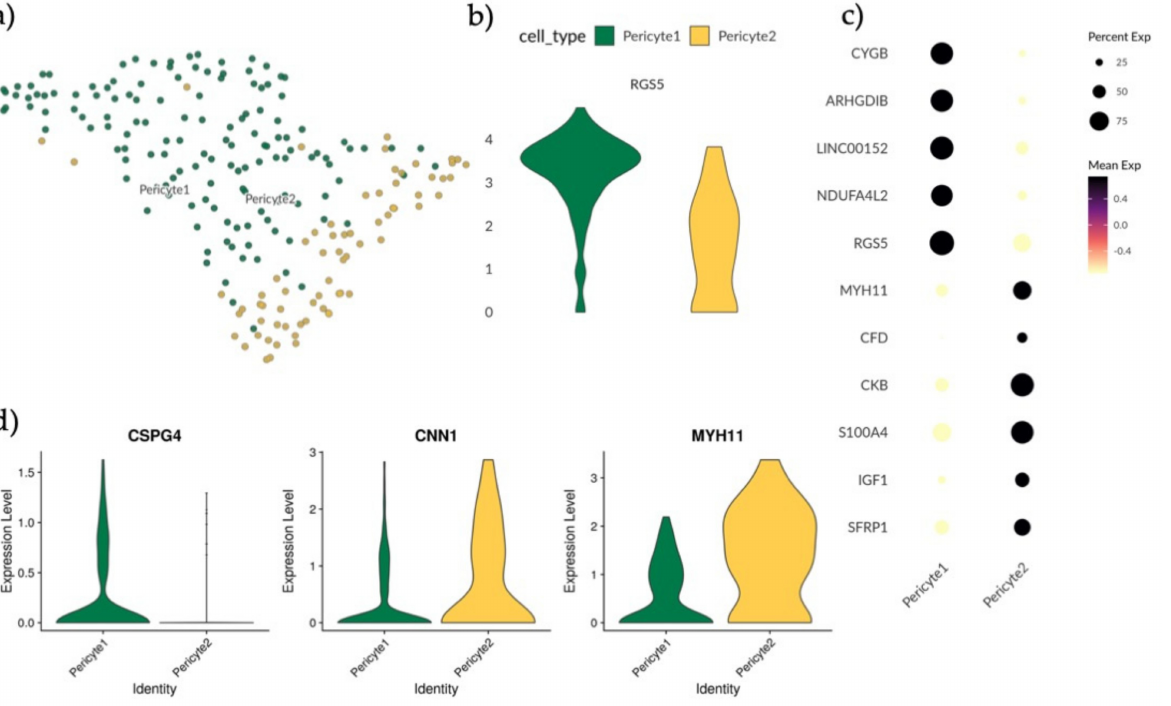
Figure 3. Analysis and subtyping of endometrial pericytes. ( a ) UMAP plot of scRNA-seq results visualizing the clustering of endometrial pericytes into two separate clusters, Pericyte1 (green) and Pericyte2 (yellow). ( b ) Violin plot displaying full distribution of RGS5 expression in Pericyte1 and Pericyte2. ( c ) Dotplot showing mean expression of top differentially expressed genes for Pericyte1 and Pericyte2 after MAST test with minimum log fold change of 1.5 and an adjusted p -value of 0.05. ( d ) Violin plots showing full distribution of marker genes CSG4, CNN1 and MYH11 in Pericyte1 and Pericyte2 with the profile CSPG4 + CNN1 low MYH11l ow for Pericyte1 and CSPG − CNN1 high MYH11 high for